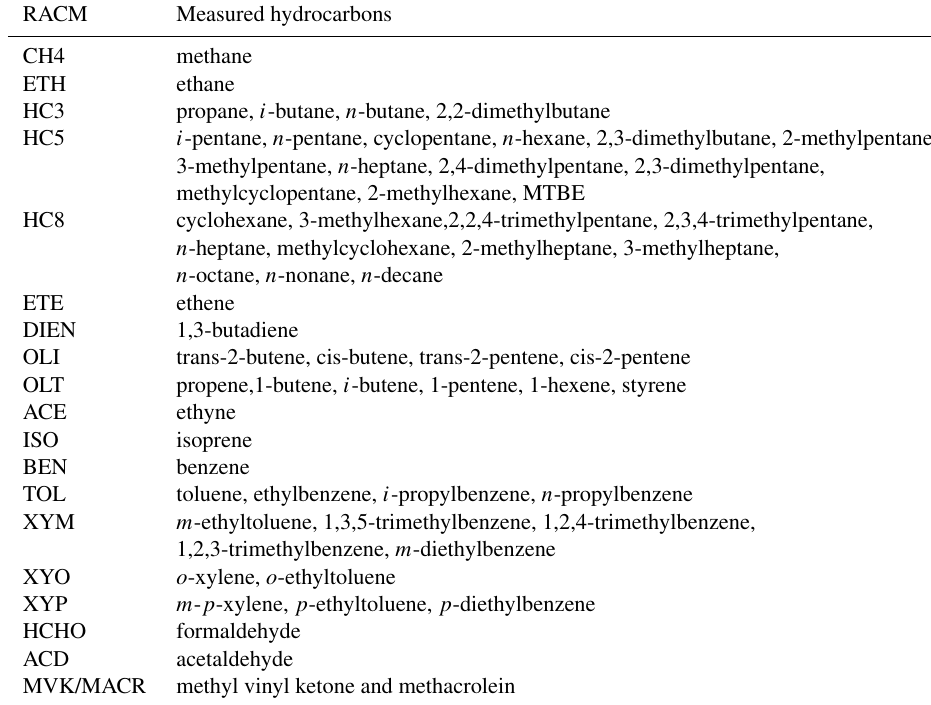
Table 3. Assignment of measured VOCs to species in the RACM 2 (Goliff et al., 2013).